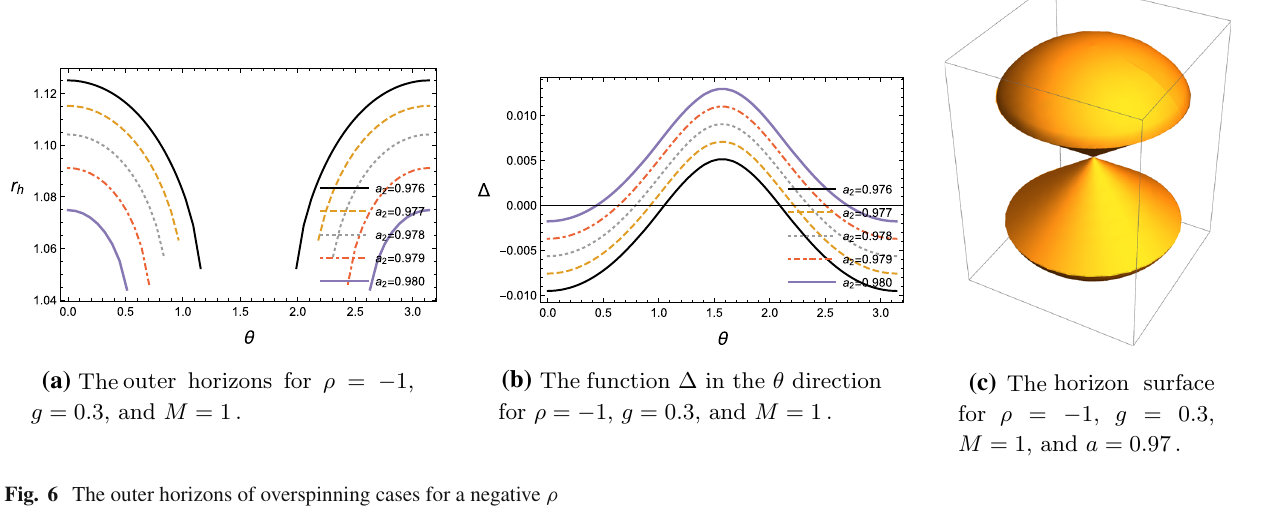
Fig. 6 The outer horizons of overspinning cases for a negative ρ